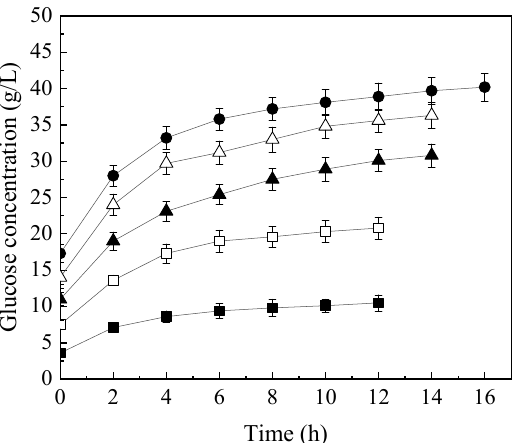
Figure 6. Glucose concentration in the production of trehalose by whole-cell biocatalysis with different initial maltose concentrations. The initial maltose concentrations are represented by different signals: filled square, 100 g/L; empty square, 200 g/L; filled triangle, 300 g/L; empty triangle, 400 g/L; filled circle, 500 g/L. The commercial maltose contains approximately 3.5% glucose. The error bars represent the standard deviation of three independent replicates.